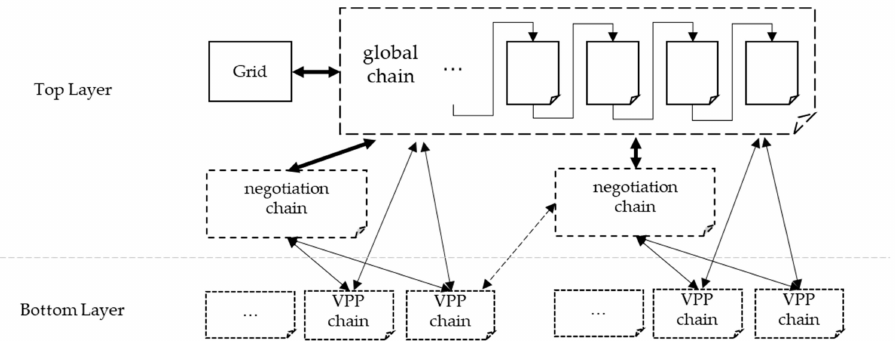
Figure 14. Schematic diagram of a potential implementation using